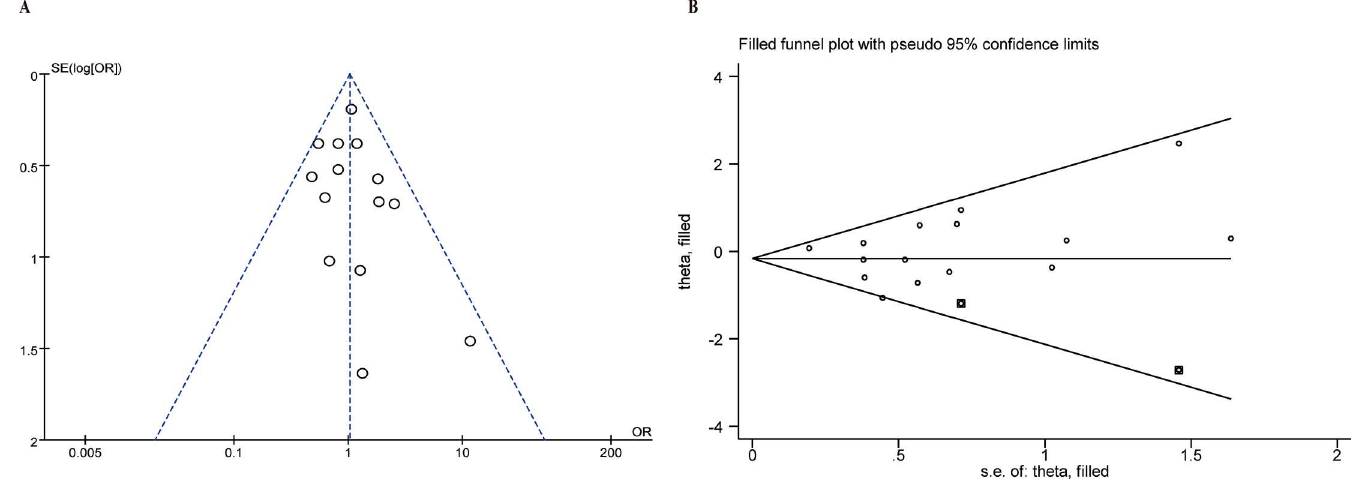
Fig 6. Funnel plot of publication bias test. Funnel plot without (A) or with (B) “trim and fill” for recessive